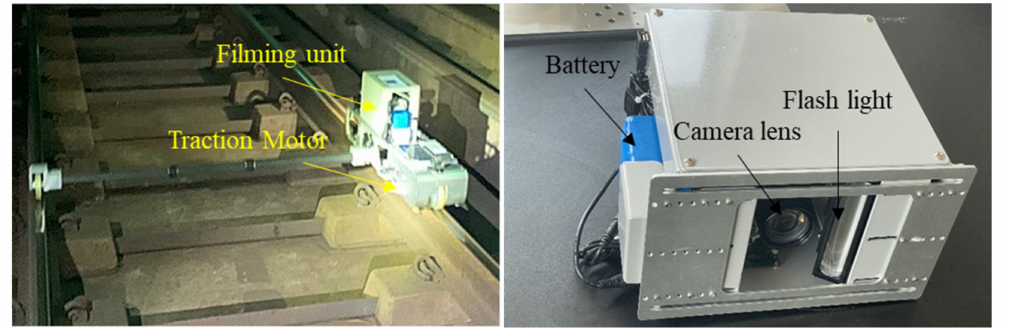
Figure 1. Setup of the image acquisition system used in this